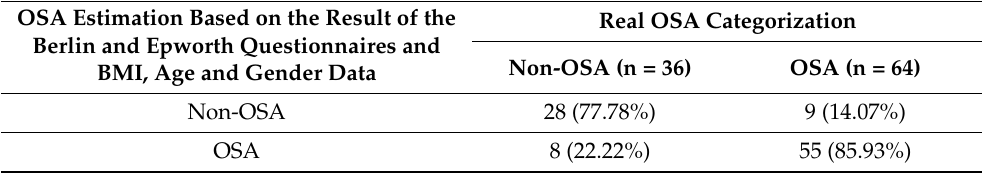
Table 11. AI prediction of OSA based on age, gender, BMI and responses to the Berlin and Epworth questionnaires (the table shows the number of cases per 100 patients and the percentage distribution of scores within the non-OSA and OSA categories). OSA: obstructive sleep apnoea. OSA Estimation Based on the Result of